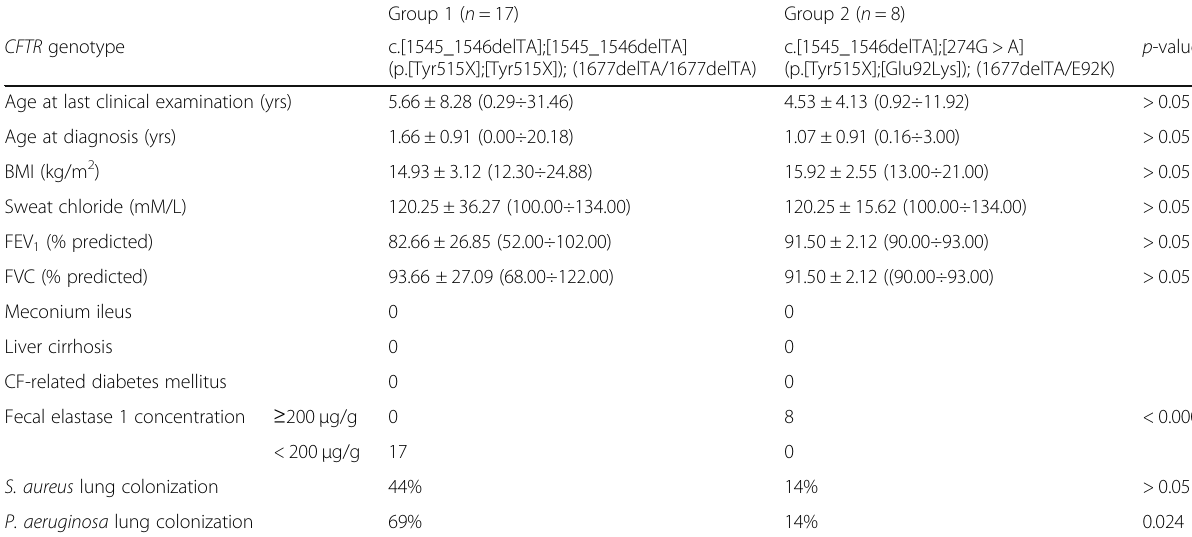
Table 2 Comparison of two groups of Chechen CF